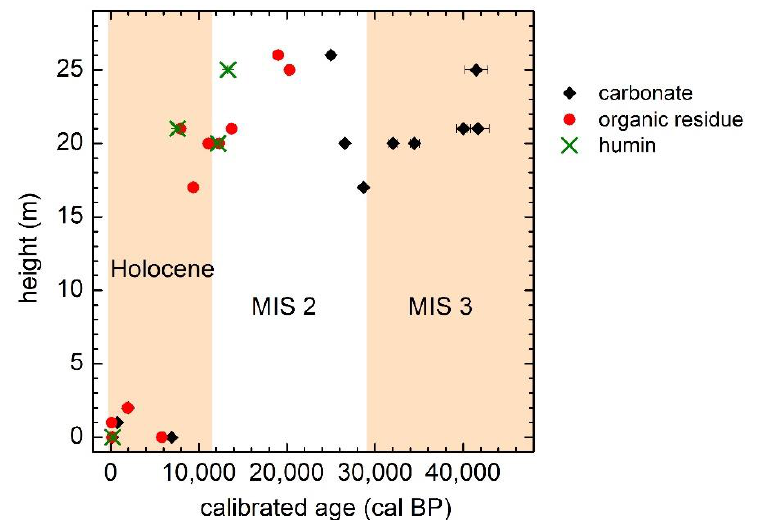
Figure 5. Positions of tufa above river bed vs. calibrated ages of Sanaderi samples: carbonate ages are corrected for hard-water effect of 1350 years and organic and humin for 240 years.